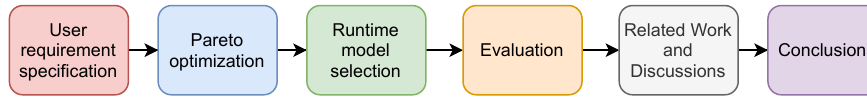
Figure 5. A Step-by-Step View of the Proposed